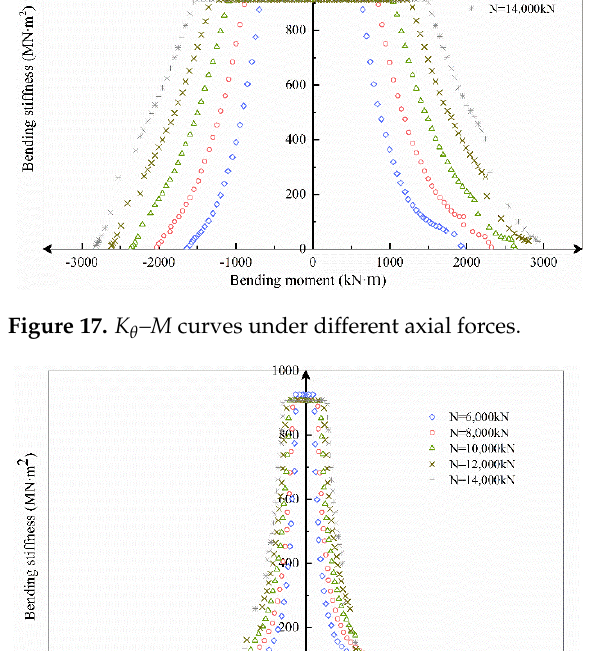
Figure 17. K θ –M curves under different axial forces.